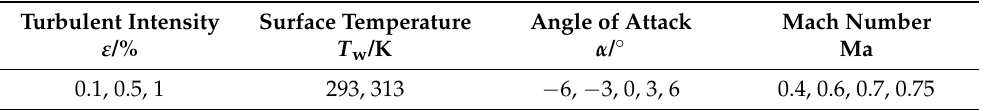
Table 2. Operating conditions.